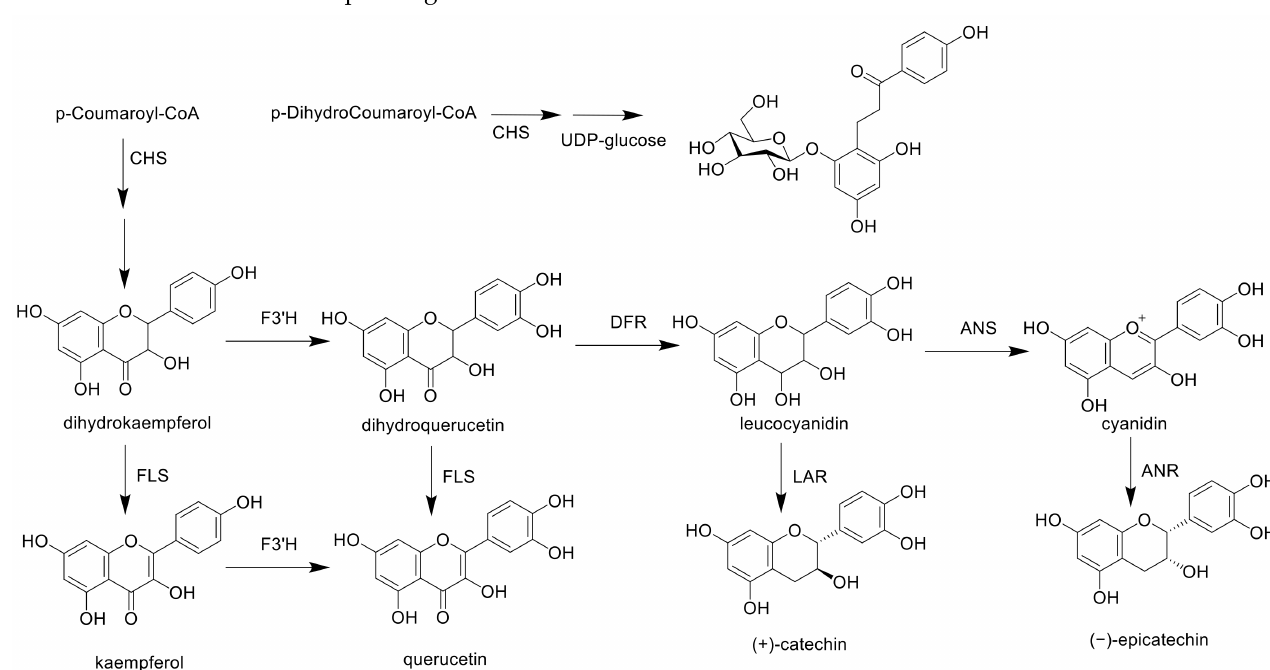
Figure 6. Partial schematic representation of flavonoid biosynthesis. CHS : chalcone synthase; UDP-glucose : uridine diphosphate glucose; F3 (cid:48) H : flavonoid 3 (cid:48) -hydroxylase; FLS : flavanol synthase; DFR : dihydroflavanol 4-reductase; LAR : leucoanthocyanidin reductase; ANS : anthocyanin synthase; and ANR : anthocyanidin reductase.